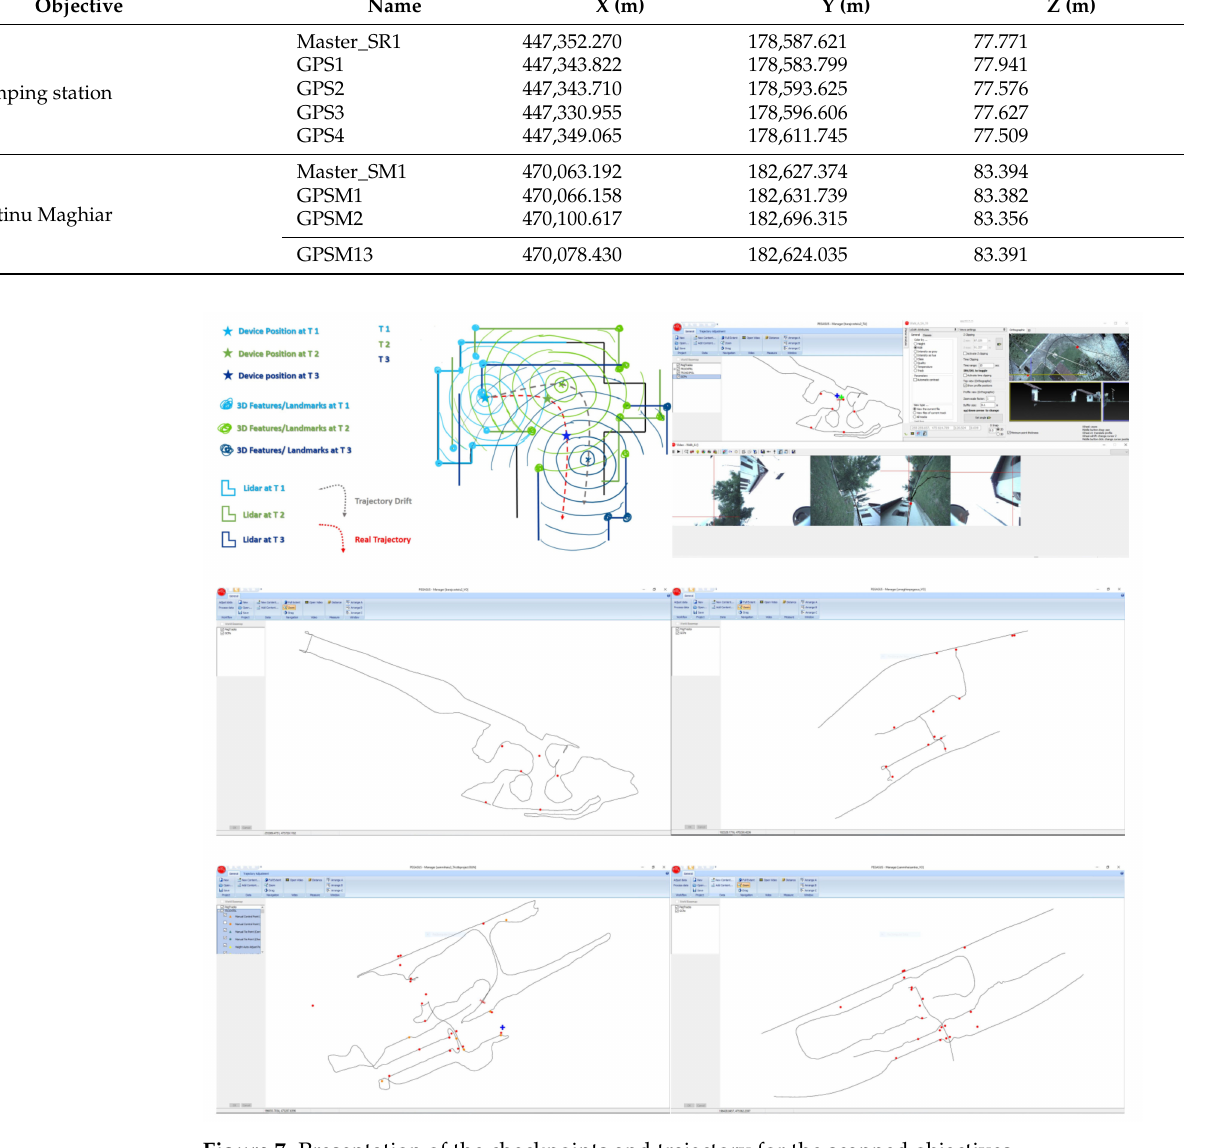
Figure 7. Presentation of the checkpoints and trajectory for the scanned